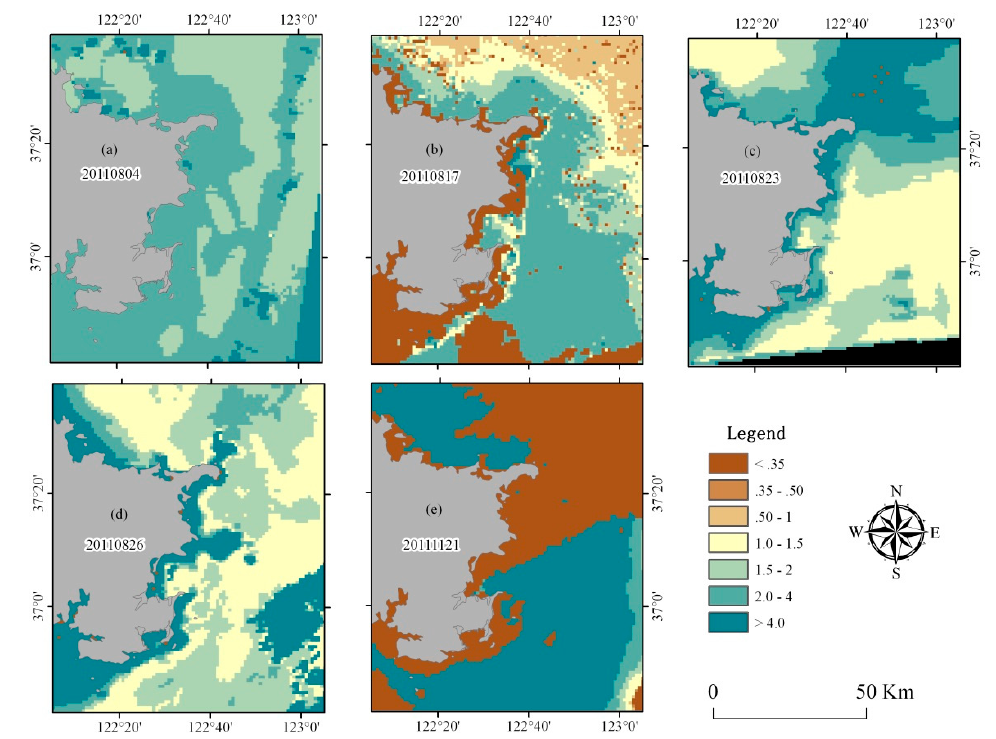
Figure 10. Time series variation characteristics of the sorting of surface particles before and after the passage of typhoon Muifa on August 8, 2011.